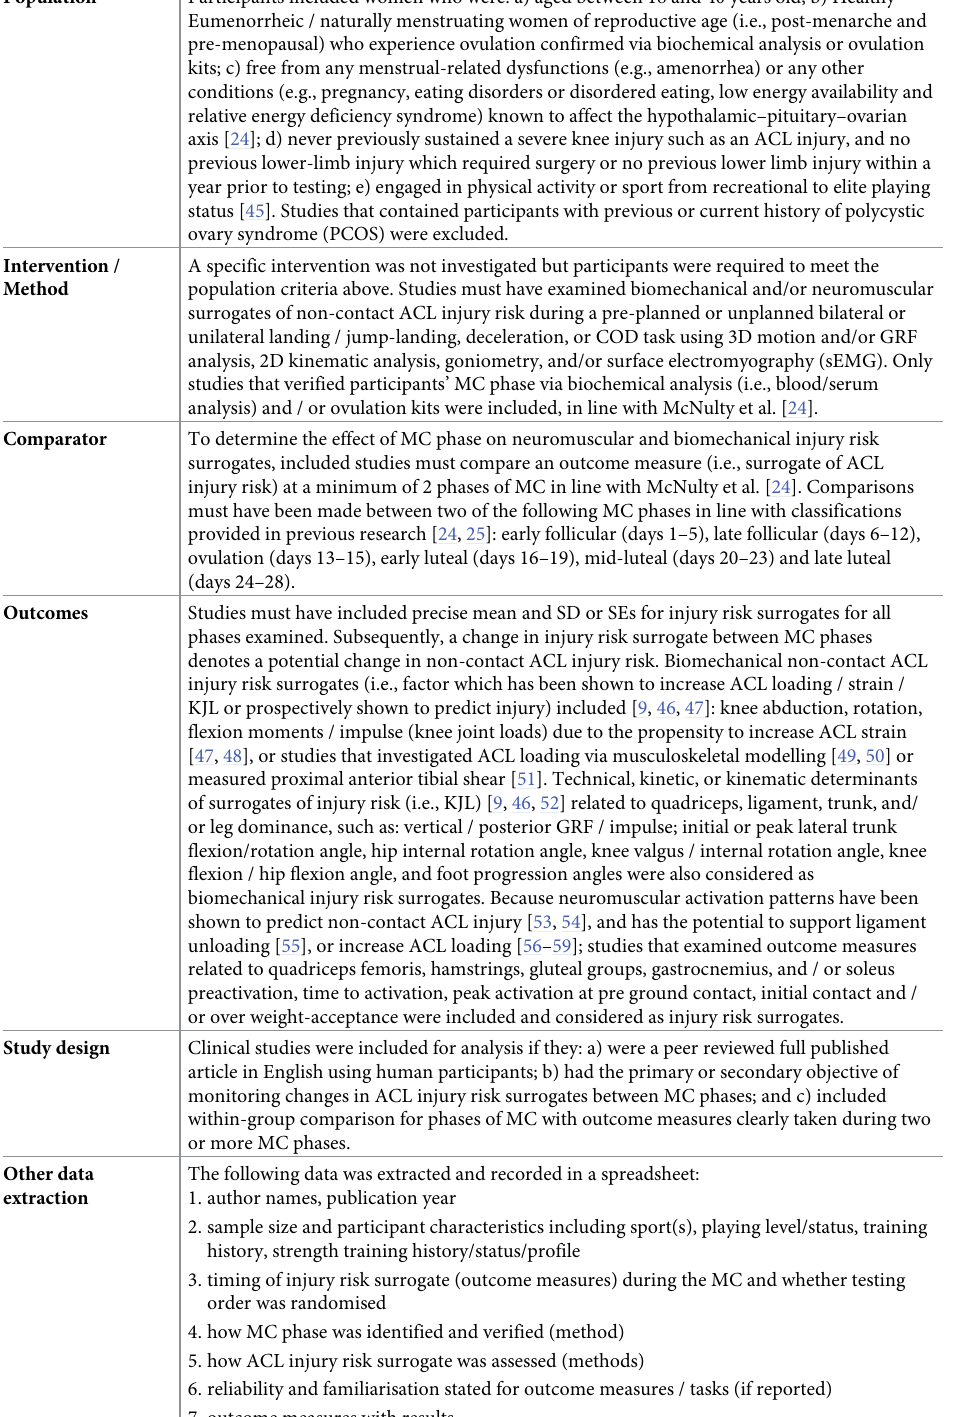
Table 1. Consideration of population, intervention, comparator, outcomes and study